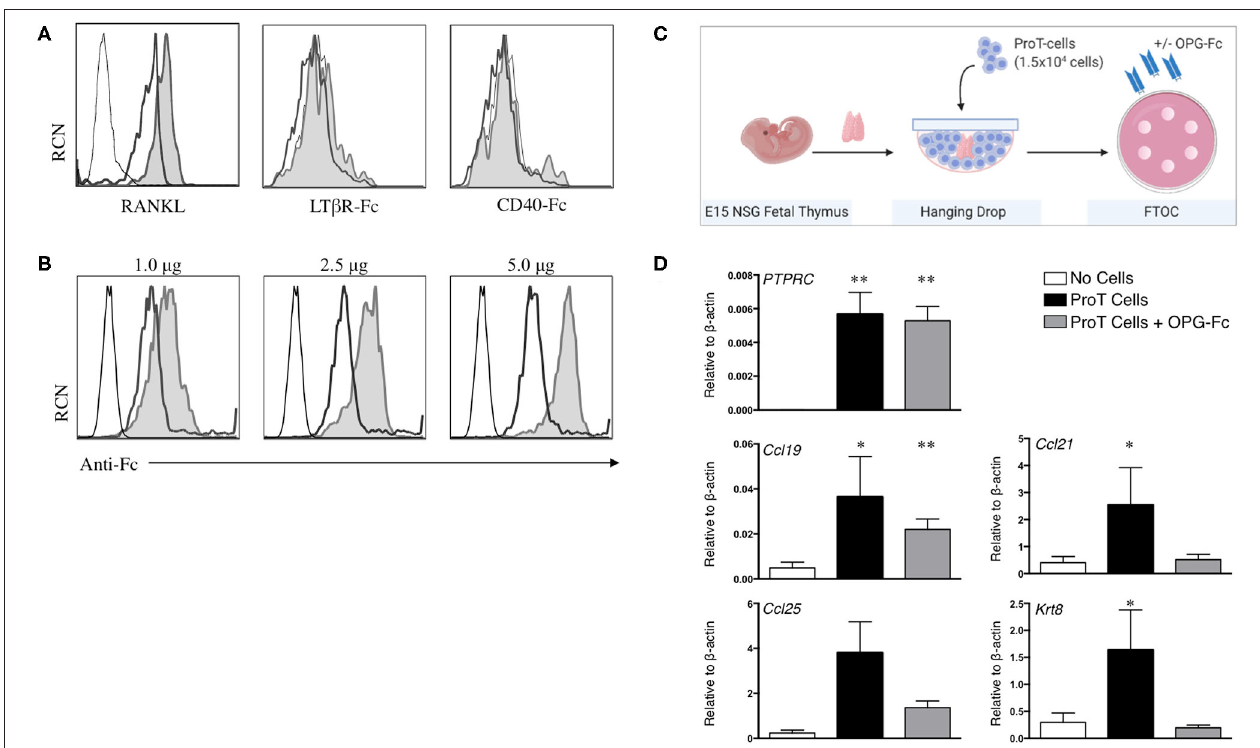
FIGURE 2 | RANKL expression on in vitro -derived human proT cells is potentially involved in lymphostromal crosstalk with the thymic stroma. (A) Flow cytometric analysis for RANKL, LT αβ and CD40L expression on day 11 in vitro -derived CD34 + CD7 + -gated in vitro -derived proT1 (open, thick line) and proT2 cells (shaded). IgG controls are included as a control (open, thin line). These results are representative of > 3 independent experiments for RANKL and LT αβ and 2 independent experiments for CD40L. (B) Flow cytometric analysis of 2 × 10 5 day 10 in vitro -derived CD34 + CD7 + -gated proT cells showing OPG-Fc staining (shaded), IgG control (open, thick line) and unstained cells (open, thin line). OPG-Fc was used at the doses indicated. (C) OPG-Fc was used to block RANK-RANKL interactions in fetal thymic organ culture (FTOC). A schematic of the experimental set-up is shown. (D) Gene expression analyses from day 5 NOD/SCID/ γ c null FTOCs. QPCR analysis for the expression of human PTPRC (CD45), and mouse Ccl25 , Ccl19 , Ccl21 , and Krt8 (Cytokeratin-8) for lobes containing no cells ( n = 8), proT cells ( n = 7) or proT cells with OPG-Fc ( n = 7). Transcript levels for all genes were normalized to mouse β -actin. The results shown are representative of at least 3 independent experiments. Statistical analysis was performed using the Kruskal-Wallis one-way analysis of variance with a calculated significance level of p > 0.05, followed by post-hoc Dunn’s test. All data are represented as mean ± SEM, with asterisks representing statistical significance as compared to the control (no cells) group (* p < 0.05, ** p <